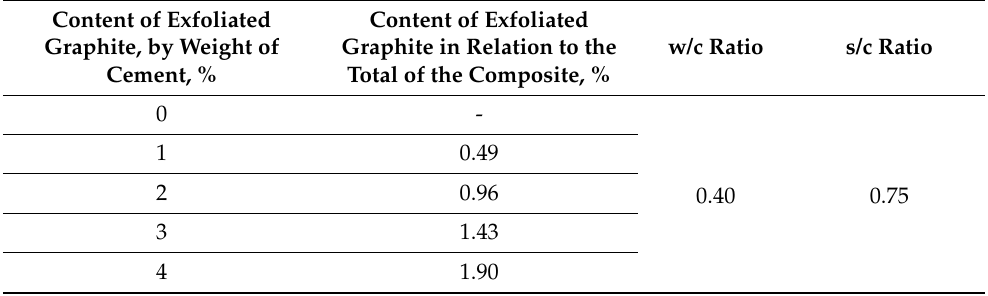
Table 1. Proportions of prepared cement